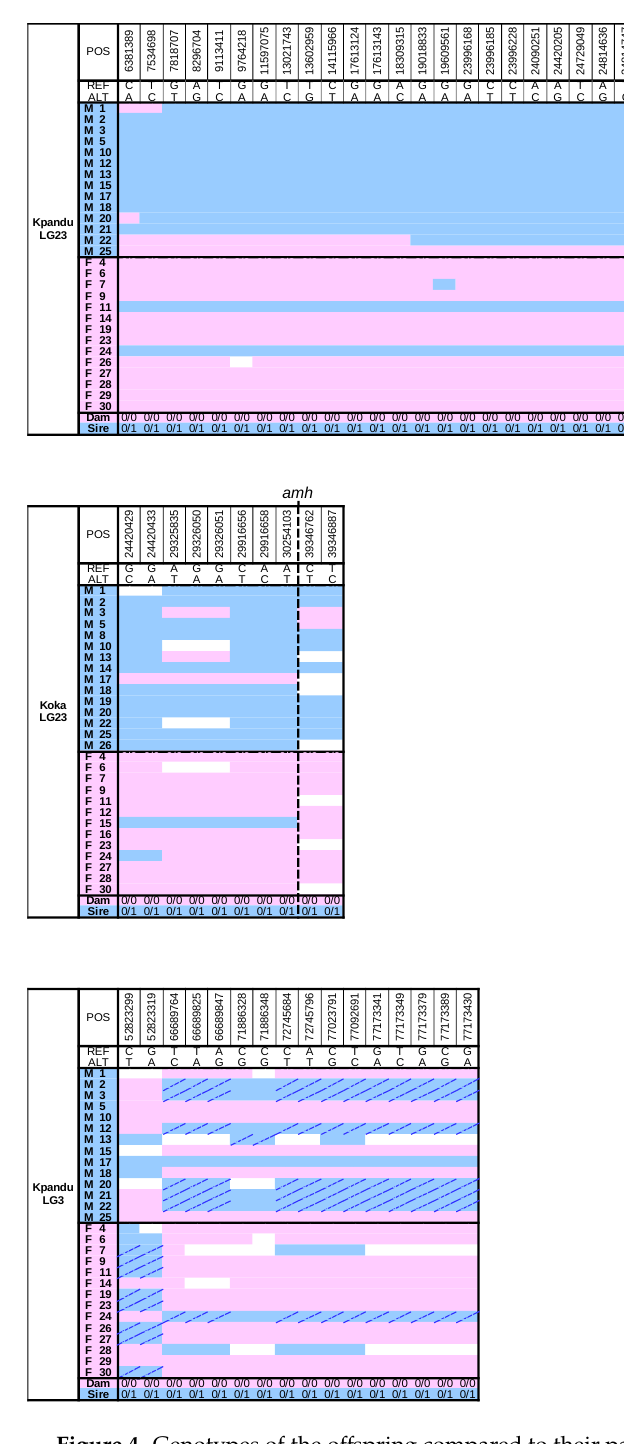
Figure 4. Genotypes of the o ff spring compared to their parents inferred from ddRAD FET significant sites following an XX / XY pattern. Pink cells indicate an individual having the same genotype as their mother at this site whereas blue cells indicate an individual having the same genotype as their father at this site (dashed cells indicate homozygous YY sites). White cells are missing data. Only sites having both parents and at least half males and females of the o ff spring sequenced were kept here. Those tested for a ZZ / ZW pattern are shown in Figure